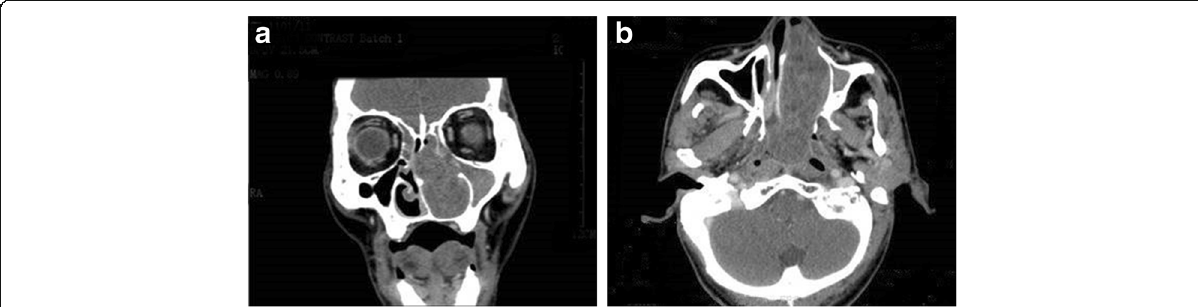
Fig. 1 a A coronal CT image showing a soft tissue mass filling the left nasal cavity, causing obstruction of the left frontal and ethmoid sinuses. b Axial enhanced CT showed a soft tissue mass in the left nasal cavity featuring mild to moderate heterogeneous enhancement. The tumor extends posteriorly to the choana and nasopharyngeal region, with an indistinct border from the soft tissue of the lateral nasopharyngeal wall